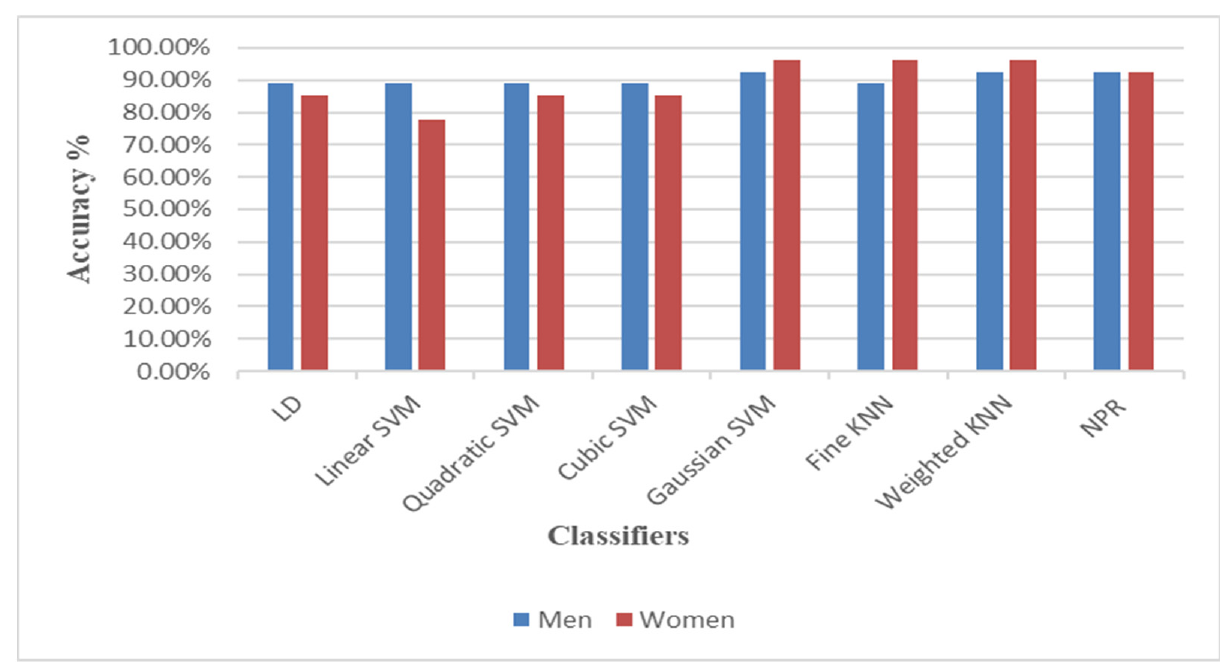
Figure 9. Classi fi cation results (accuracy) for men and women datasets. Figure 9. Classification results (accuracy) for men and women datasets.